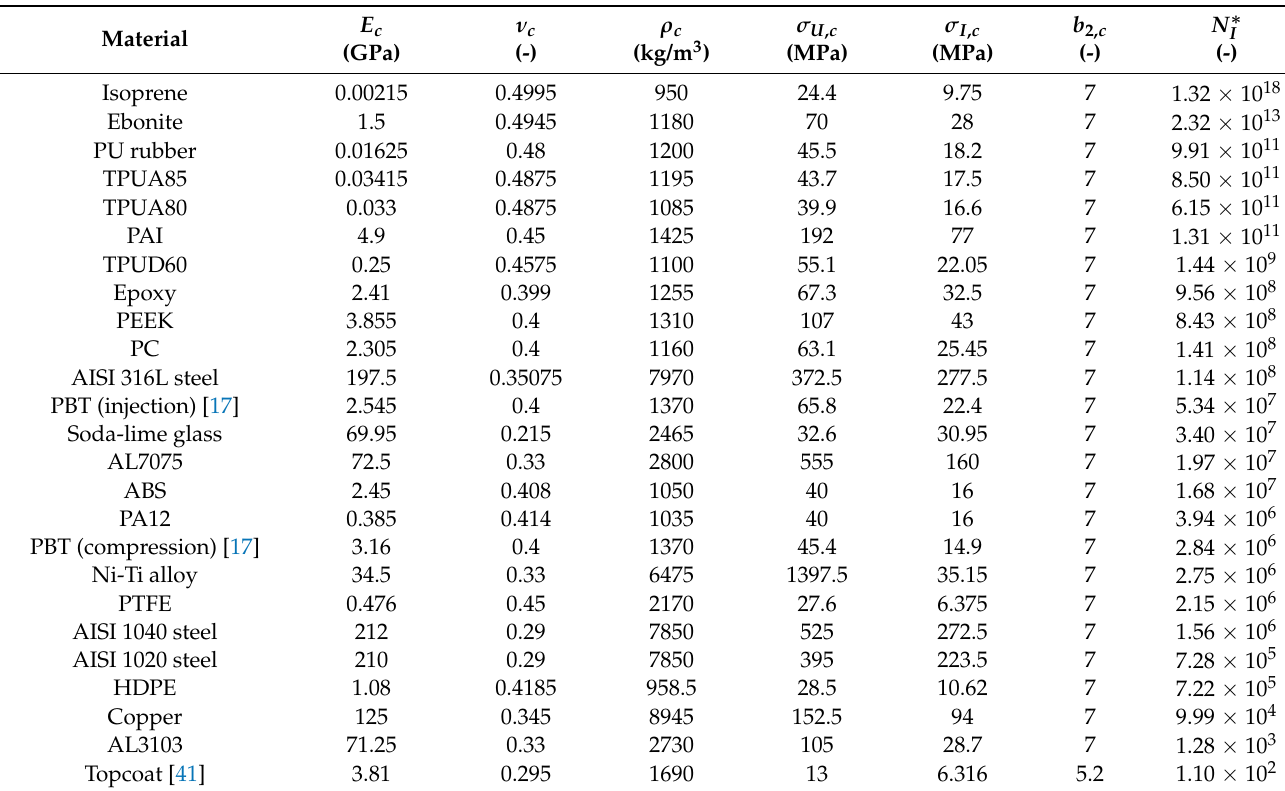
Table 2. Material parameters and lifetimes according to the Springer model for arbitrary